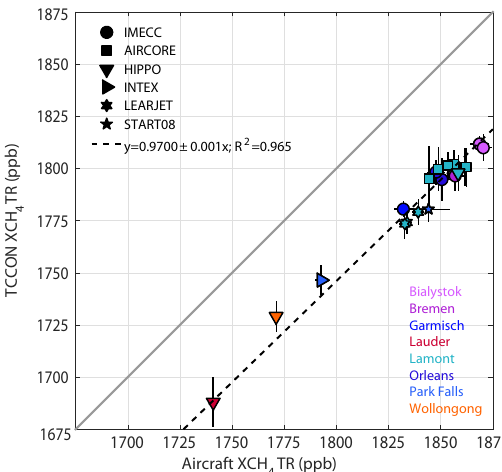
Figure A2. Calibration curve of TCCON X t 2015, their Fig. 8). Site colors are as in Fig. 1. Aircraft campaigns are described in Table 6 of Wunch et al.